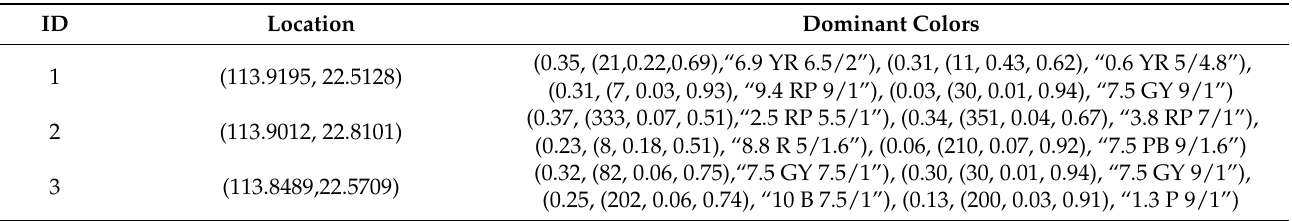
Table 1. The data structure of the DCUF. The Munsell color system divides hues into ten main colors: red (R), yellow–red (YR), yellow (Y), green–yellow (GY), green (G), blue–green (BG), blue (B), purple–blue (PB), purple (P), and red–purple